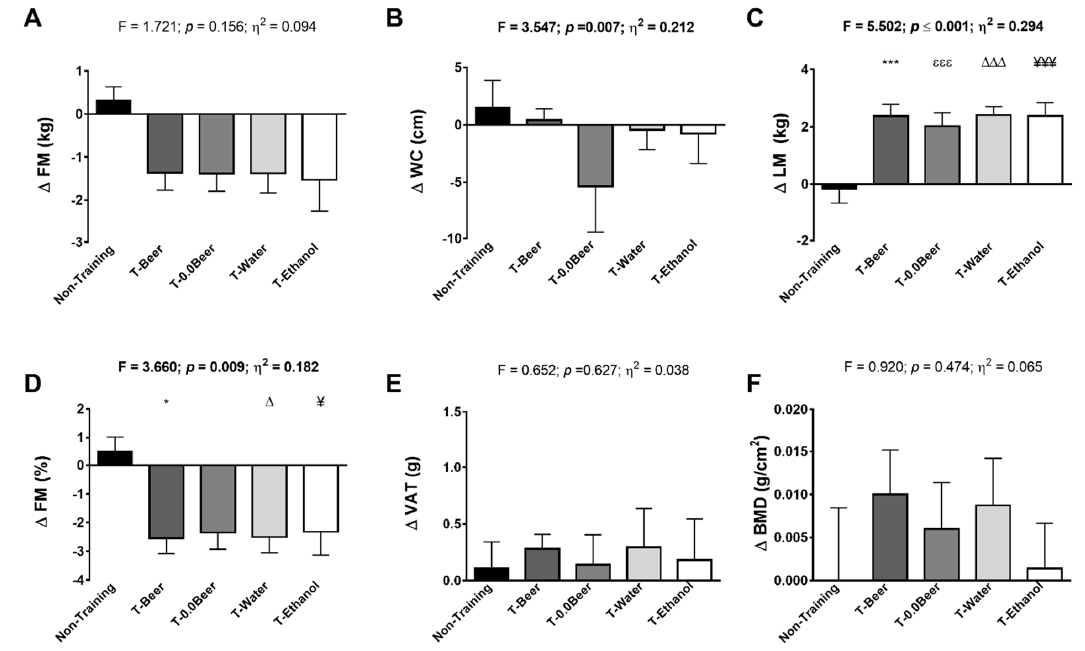
Figure 2. Changes in ( A ): fat mass (FM), ( B ): waist circumference ( WC ), ( C ): lean mass ( LM ), ( D ): fat mass ( FM ), ( E ): visceral adipose tissue ( VAT ), and ( F ): bone mineral density (BMD) after the intervention study among the five groups. Significant differences between groups applying an analysis of covariance adjusting by baseline values, with post hoc Bonferroni-corrected t-test, are indicated as: Non-training group vs. T-Beer (* p < 0.05), (*** p < 0.001); Non-training group vs. T-0.0Beer ( εεε p < 0.01); Non-training group vs. T-Water ( ∆ p < 0.05), ( ∆∆∆ p < 0.001); and Non-training group vs. T-Ethanol (¥ p < 0,05), (¥¥¥ p ≤ 0.001). Data are shown as means ± standard error of the mean. Abbreviations: FM, fat mass (kg); WC, waist circumference; LM, lean mass; FM %, fat mass percentage; VAT, visceral adipose tissue; BMD, bone mineral density; N-T, non-training group; T-Beer, group that performed HIIT and ingested alcohol beer; T-0.0Beer, group that performed HIIT and ingested non-alcoholic beer; T-Water, group that performed HIIT and ingested sparkling water; T-Ethanol, group that performed HIIT and ingested sparkling water with alcohol added.